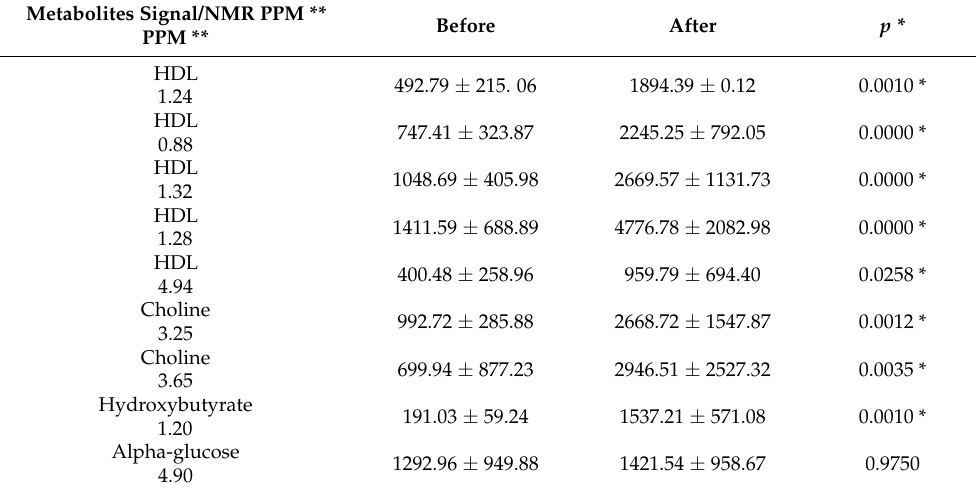
Table 3. Comparison between metabolites before and after intervention with mixed dietary fiber in women recruited from the Blood Donor Centre of Jo ã o Pessoa, PB,